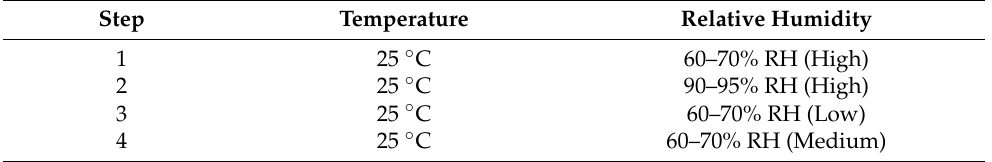
Table 1. Conditions used for equilibrium humidity